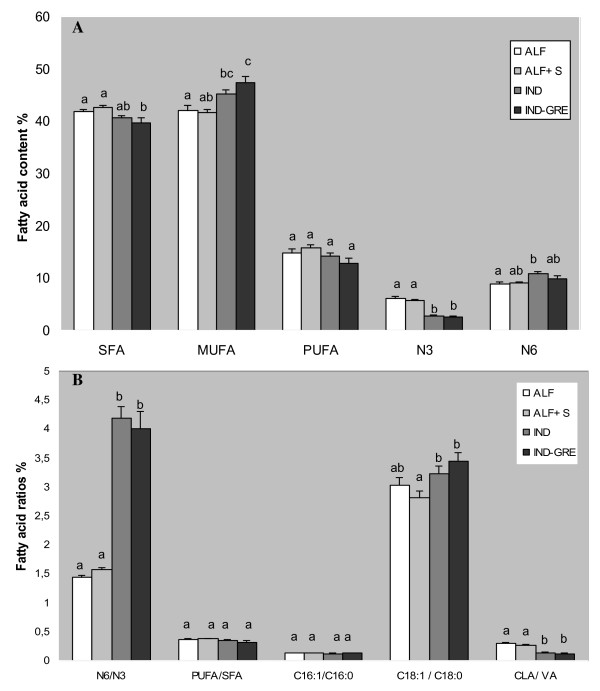
Mean fatty acid composition of the semitendinous muscle in Rasa Aragonesa lambs for each feeding system. A: Mean values of total satured (SFA), monounsatured (MUFA) and polyunsatured (PUFA) fatty acids, and n-3 and n-6 PUFA composition (expressed as the percentage of total fatty acids). B: Fatty acid ratios. ALF: Grazing Alfalfa; ALF+S: Grazing alfalfa with supplement for lambs; IND-GRE: Indoor lambs with grazing ewes; and IND: Indoors. Different subscripts differ with at least P < 0.05. The ratio of PUFA/SFA was calculated as (C18:2+C18:3+C20:4+C20:5+C22:4+C22:5+C22:6)/(C10:0+ C12:0+C14:0+C16:0+C18:0+ C20:0). The ratio of n-6/n-3 was calculated as (C18:2 n-6+C20:4 n-6+C22:4 n-6)/(C18:3 n-3+ C20:5 n-3+ C22:5 n-3+ C22:6 n-3.